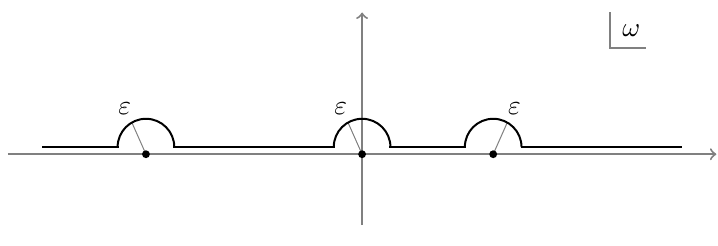
Figure 5 . The contour used to calculate A tree ( R ) in